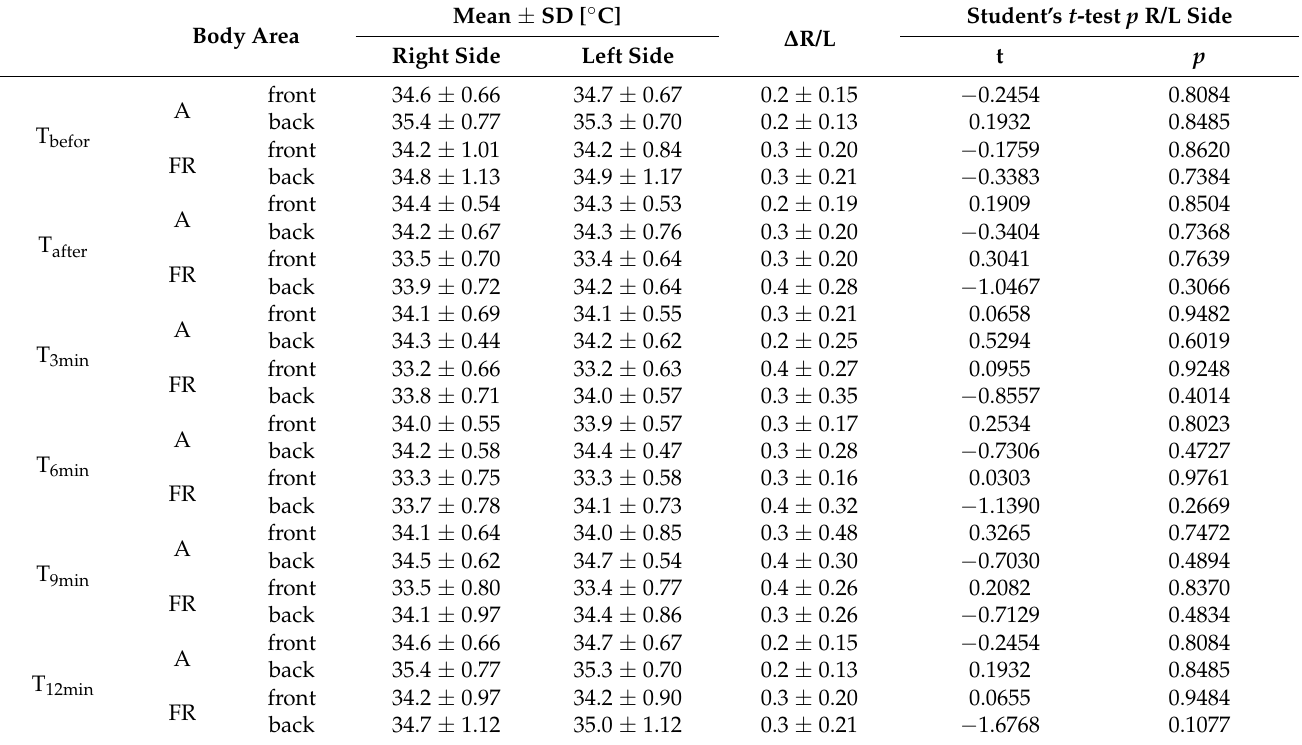
Table 1. Characteristics of mean values ( ± SD) of surface temperatures for the analyzed body regions ( ◦ C). Body